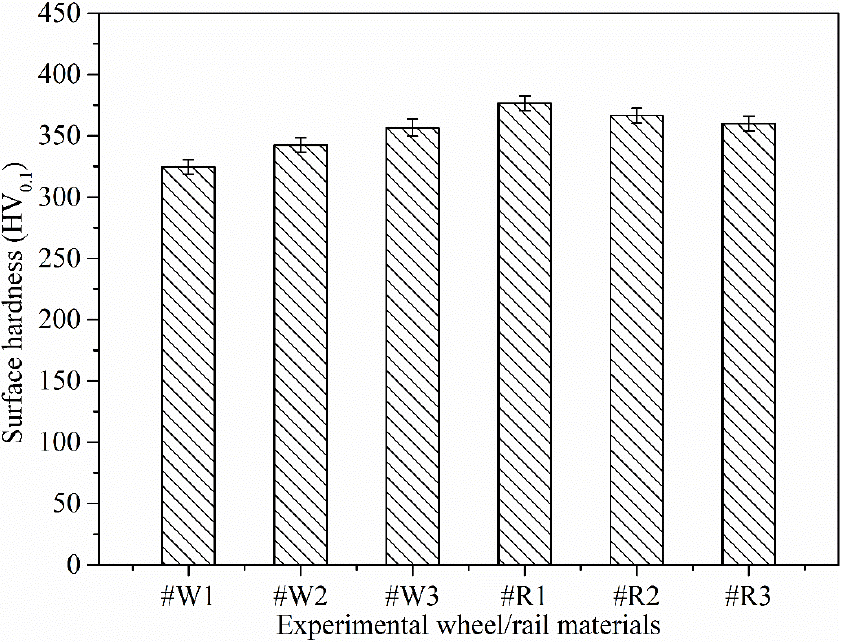
Figure 8. Surface hardness of the wheel/rail discs before the rolling-sliding contact.